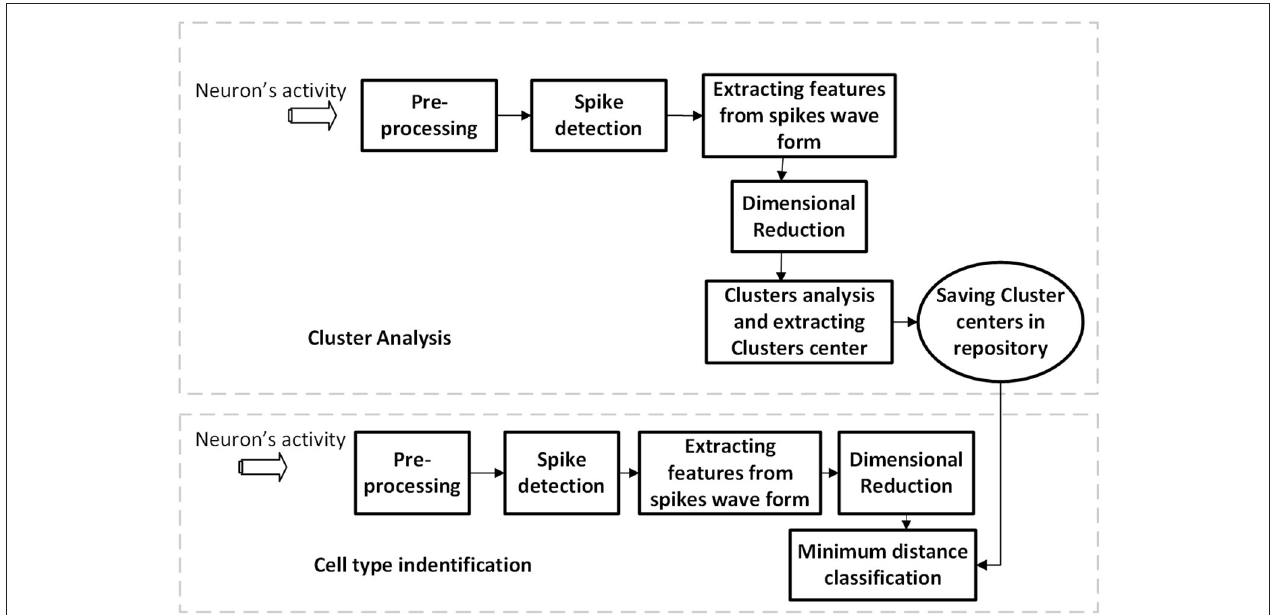
FIGURE 1 | The block diagram of our proposed method for different cell-type identification.